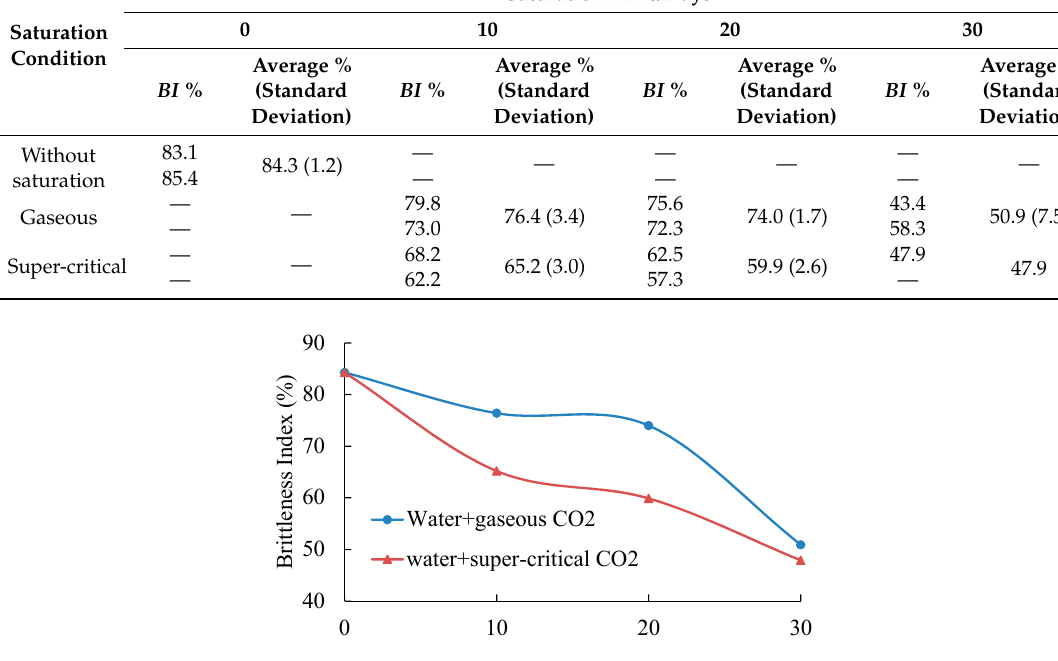
Table 5. Brittleness index for samples with different saturation conditions.